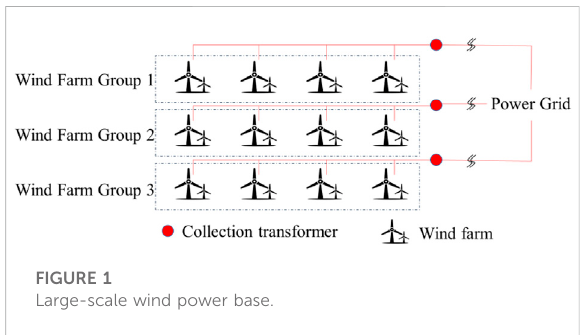
FIGURE 1 Large-scale wind power base.